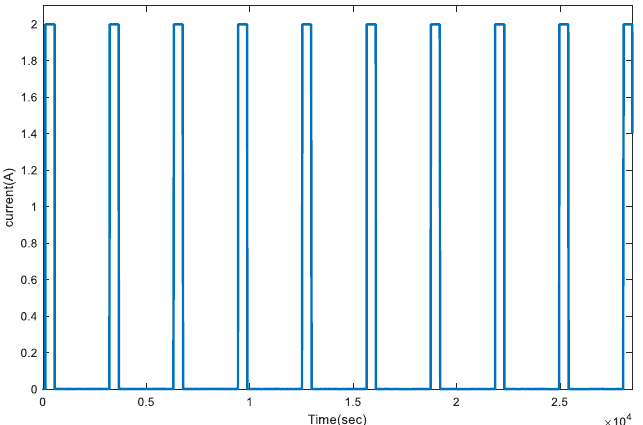
Figure 3. Test bench setup for battery testing [51,64–66].